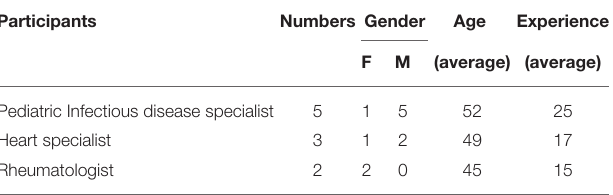
TABLE 1 | The demographic characteristics of the